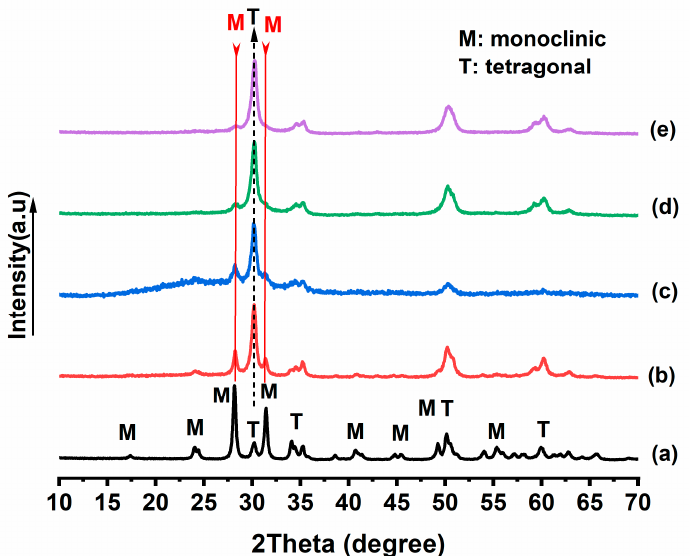
Figure 3. XRD patterns of 3.6 wt%V 2 O 5 /ZrO 2 and P loaded catalysts at different P/V ratio ( a ) ZrO 2 , ( b ) 3.6 wt%V/ZrO 2 , ( c ) P/V = 0.5, ( d ) P/V = 1, ( e ) P/V =